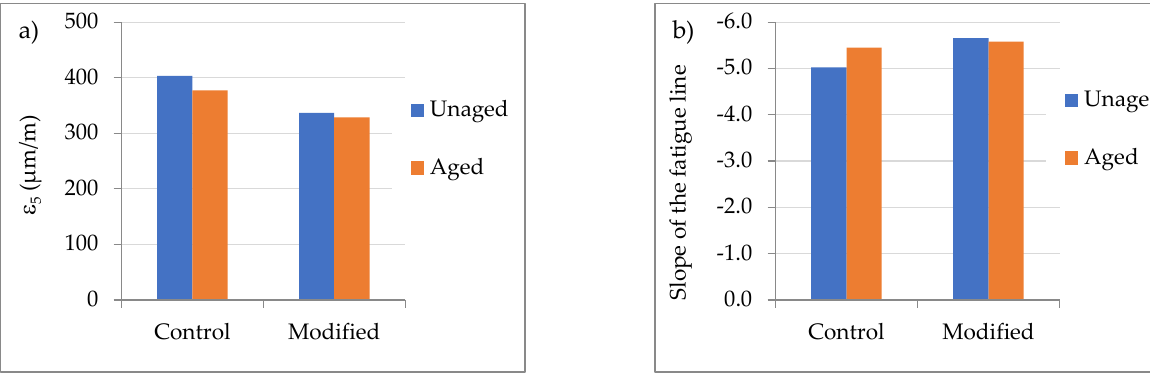
Figure 6. Complementary results of the fatigue tests: ε 5 ( a ) and slope of the fatigue line ( b